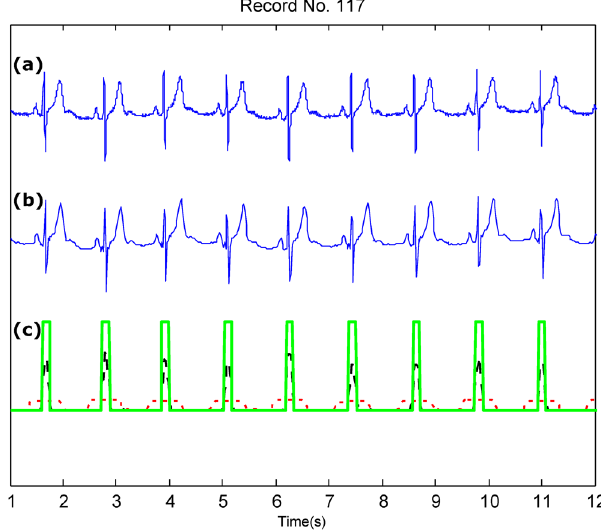
Figure 2. QRS detection over Record 117 of the MIT-BIH Arrhythmia Database with large T waves. ( a ) Original ECG signal ( b ) Compressed ECG signal using Method III ( c ) Compressed ECG signal using Method III with adaptive thresholding and detected QRS complexes (green blocks). Signal amplitudes have been manipulated to fit all signals in one figure. Here, the red dotted line represent the first moving average where the black dashed line represents the second moving average.